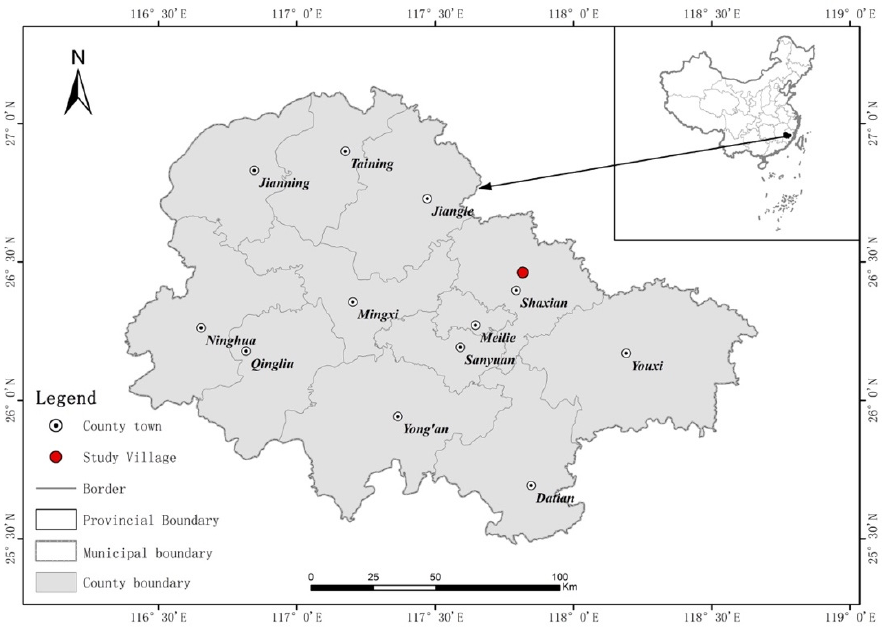
Figure 1. Location of the study village.